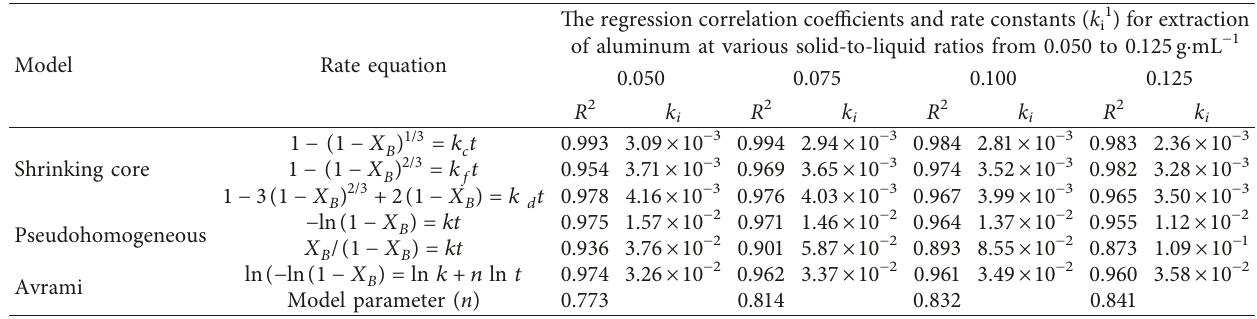
Table 1: The regression correlation coefficients and rate constants for aluminum extraction at various solid-to-liquid ratios from 0.050 to 0.125g · mL − 1 . The regression correlation coefficients and rate constants ( k i1 ) for extraction of aluminum at various solid-to-liquid ratios from 0.050 to 0.125g · mL − 1 Model Rate equation